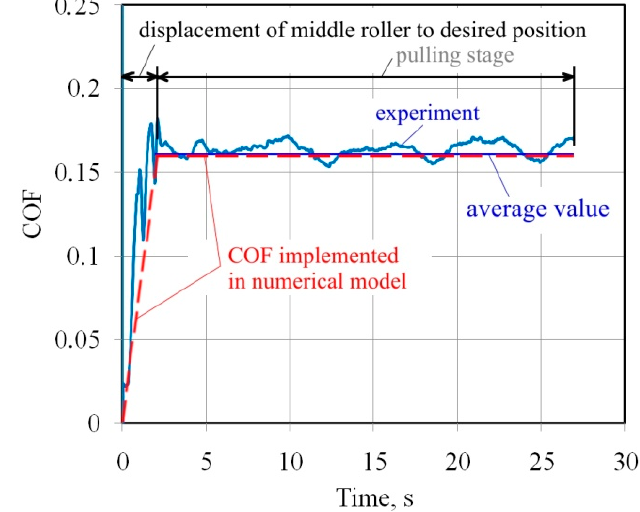
Figure 7. Experimentally determined variation of the COF during a DBS test for height of drawbead h = 18 mm and specimen width w = 20 mm.